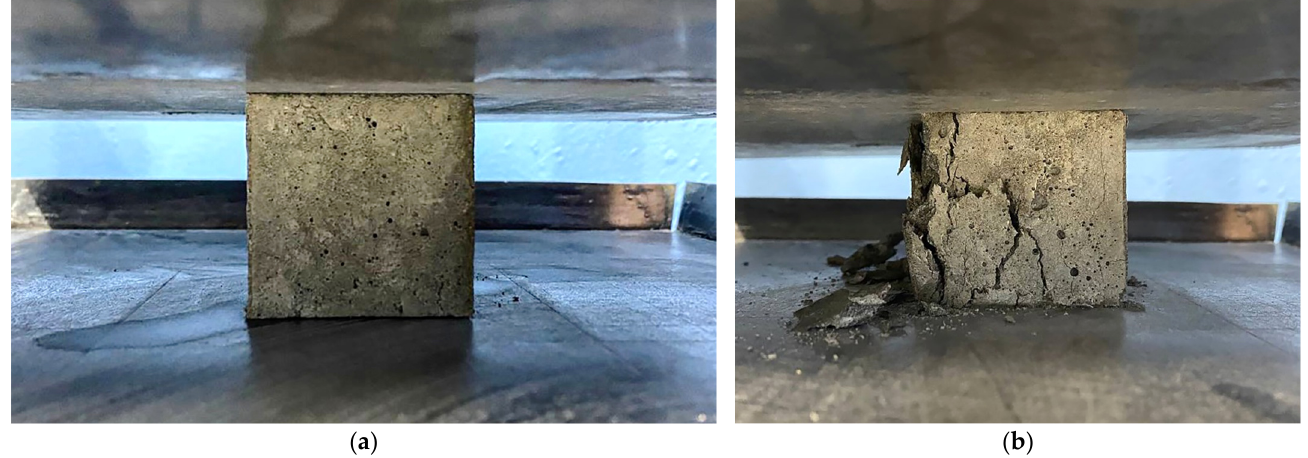
Figure 4. Photos of the testing process of control samples: ( a ) before destruction; ( b ) after destruction.